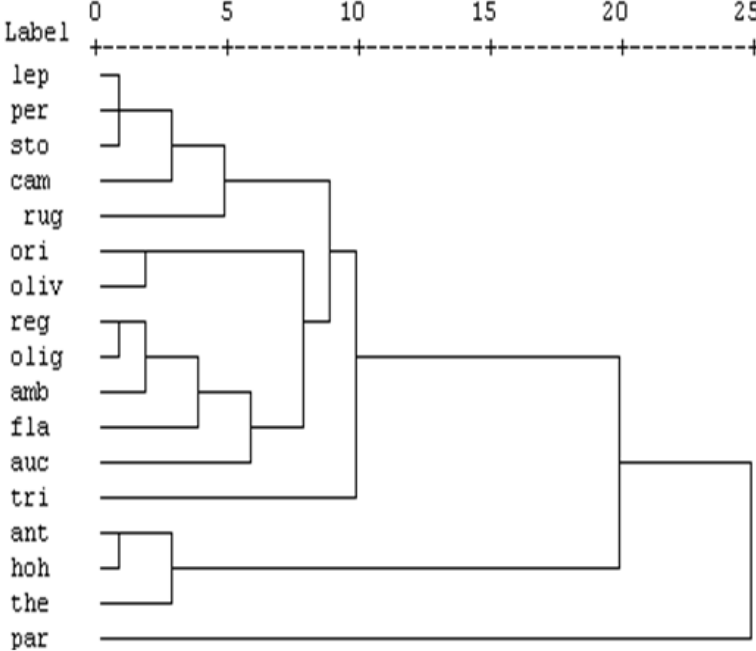
Fig. 5. Phenogram based on morphological analysing data of 17 taxa species by Ward method. (ant=A. anthoroidea, ori=C. orientalis, per= C. persica, oliv=C. oliveriana, rug=C. rugulosa f.rugulosa, fla=C. flava,olig= C. olighantha, hoh= A. hohenackeri, cam=C. camptocarpa, lep=C. leptocarpa, sto=C. stocksiana, the=A. tehranica f.tehranica, amb=C. ambigua, tri=C. trigonelloides, reg=C. regalis subsp. Divericata, par= C. paradoxa, auc=